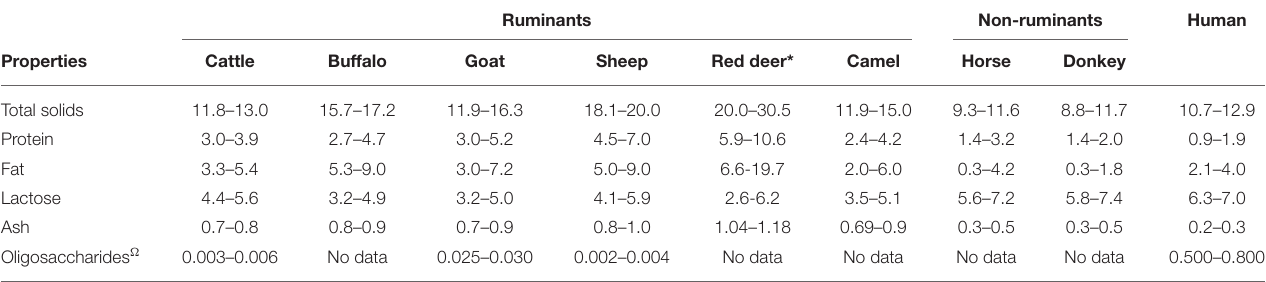
TABLE 1 | General composition (g 100 mL − 1 ) of milk from different mammalian species # .